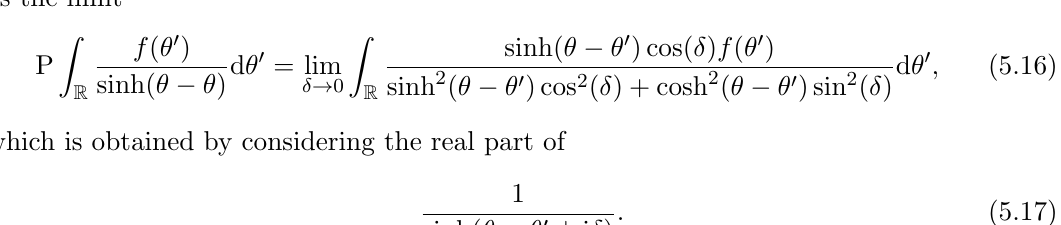
Table 4 . The (cid:12)rst column shows the spectrum of values of x n , as computed from the exact quantization condition (5.14) and the TBA equations. We used a discretization with 2 18 points and L = 35. The second column shows the values of E n ( ~ n ) for the Hamiltonian (5.18). Using the TBA equations, we have computed the functions (cid:6) ( ~ ) appearing in the l.h.s. J of the exact quantization condition, as well as the Voros spectrum x n ( E ). In (cid:12)gure 11 we plot the functions (cid:15) for E = 1 = 64, as a function of (cid:18) , as well as the horizontal lines at (cid:25) J and 3 (cid:25) , which intersect (cid:6) ( ~ ) in four points which give the (cid:12)rst four values of the spectrum J of ~ . For the numerical solution of the TBA system we have used a Fourier discretization in an interval ( L; L ) with L = 35 and N = 2 18 points. The principal value is (cid:0)